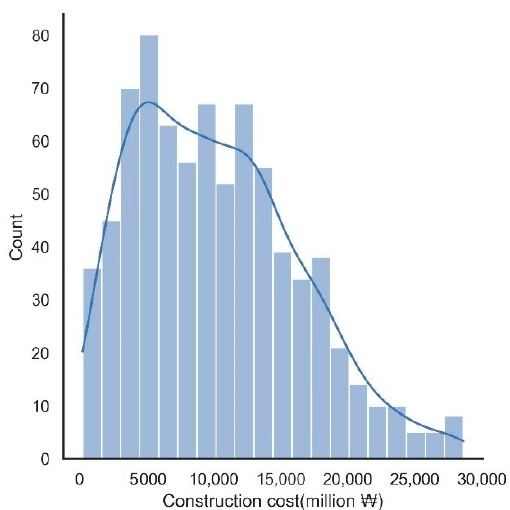
Figure 2. Distribution of collected construction cost data.